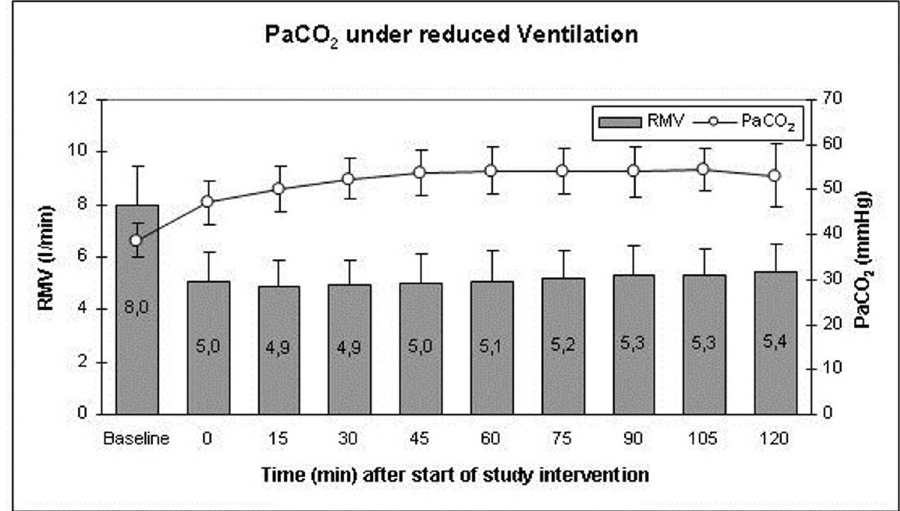
Figure 1. Change of Respiratory Minute Volume (RMV, bars) and concomitant increase of arterial partial pressure of carbon dioxide (PaCO 2 , line plot). At the beginning of the study intervention, RMV was reduced by 40%. Thereafter, minor corrections were made according to blood gas analyses. Data presented as Mean ± SD; 1-way ANOVA for Repeated Measurements; *p < 0.05, **p < 0.01, ***p < 0.001, plots and error bars presented as Mean ± SD (standard deviations).